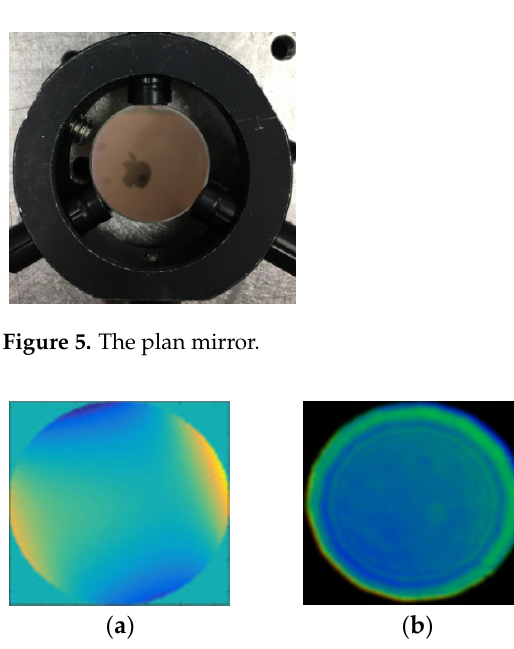
Figure 6. The measurement results with ( a ) PR: root-mean-square (RMS) = 0.0392 , peak value (PV) = 0.2501 ; ( b ) ZYGO: RMS = 0.023 , PV = 0.294 .